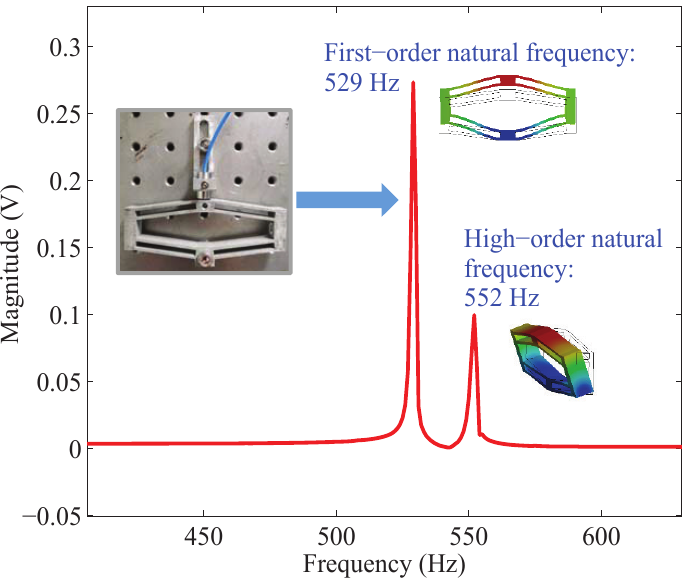
Figure 7. Dynamic performance tests of the bridge-type